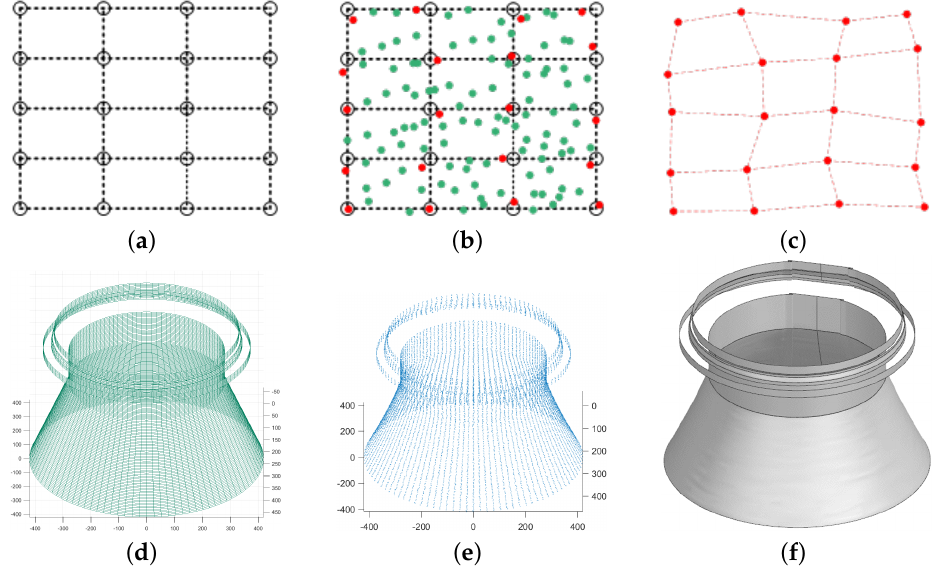
Figure 12. The process of grid point offset. ( a ) The CAD grid points with a resolution of 6 mr. ( b ) Nearest neighbors of the CAD grid point in the point cloud model. ( c ) The NURBS of real workpiece constructed by grid point. ( d ) All of the CAD model grid point. ( e ) The offset data points according grid point. ( f ) Modeling